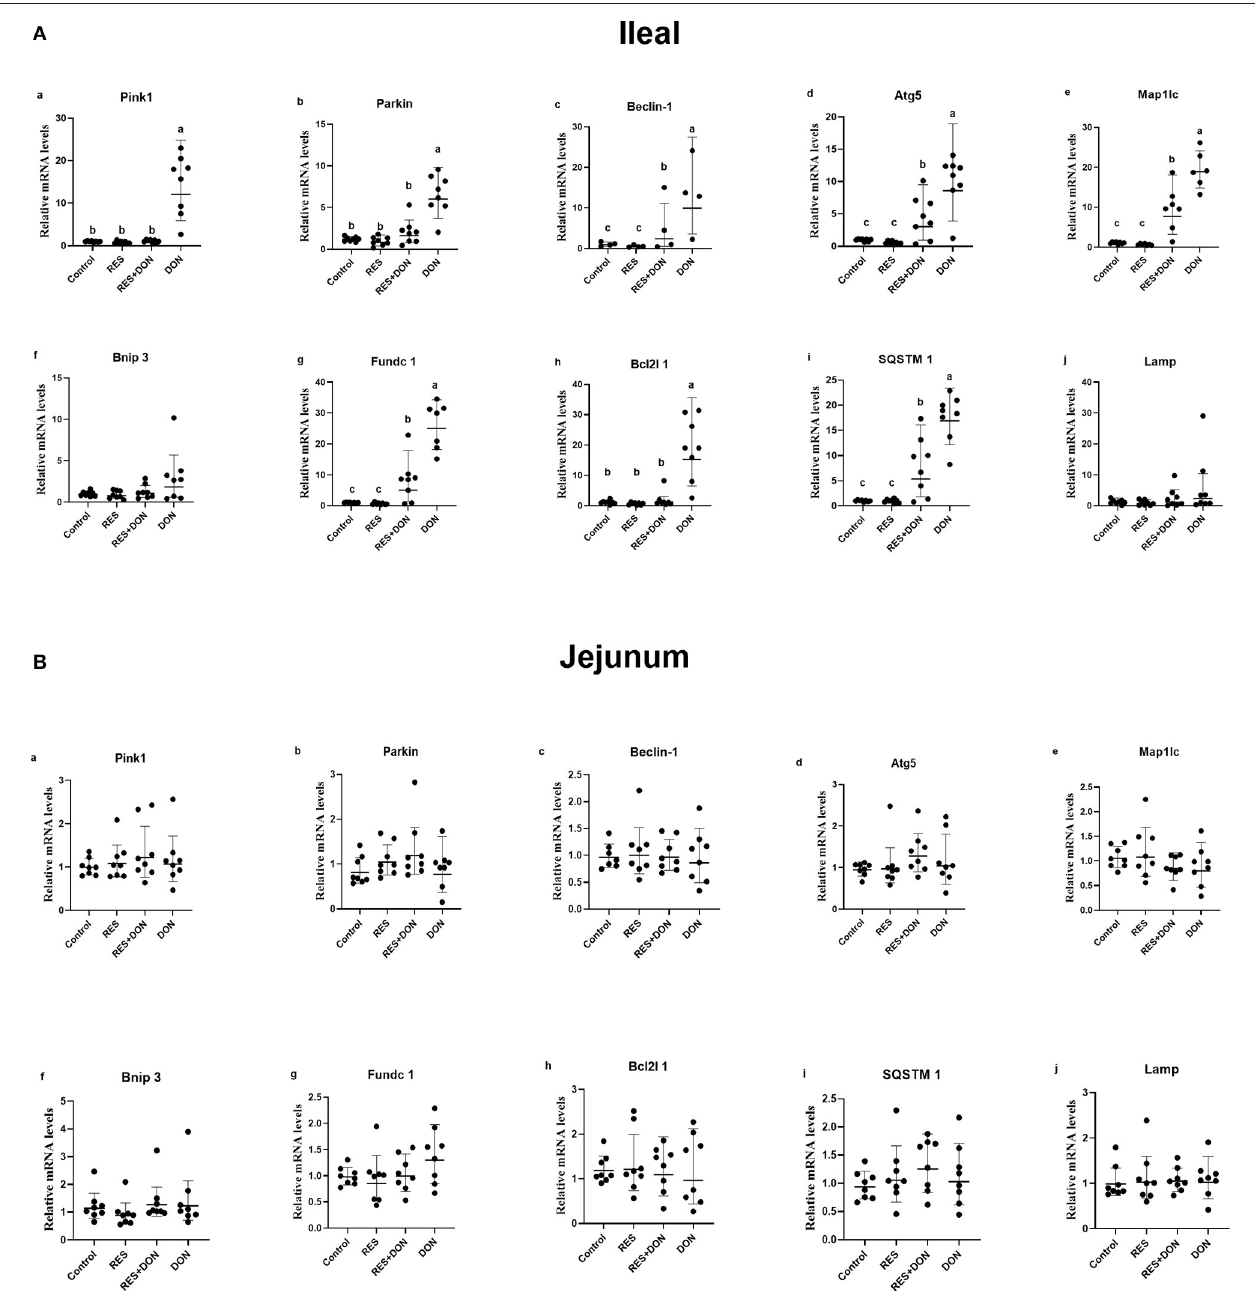
FIGURE 1 | Dietary supplementation with RES alleviated the negative effects on mRNA expression levels of mitophagy-related genes challenged with DON. Data were expressed as means ± SEM of at least three independent experiments. (A,B) Values with different letters are significantly different ( P < 0.05).